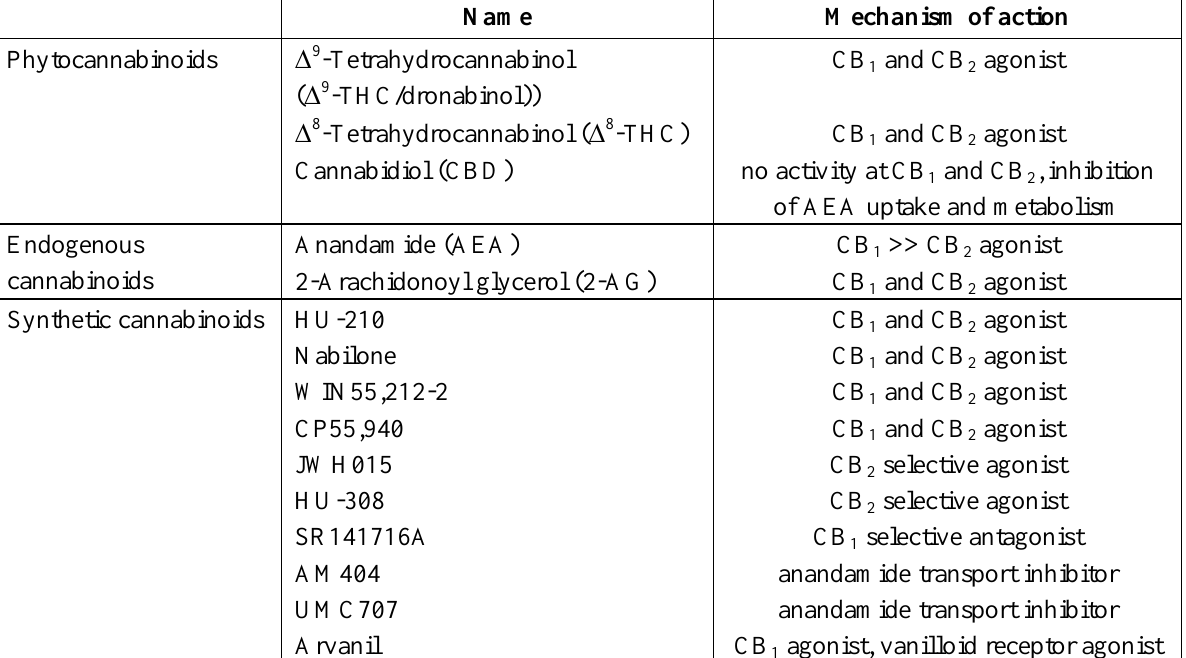
Table 1. Cannabinoids mentioned in this